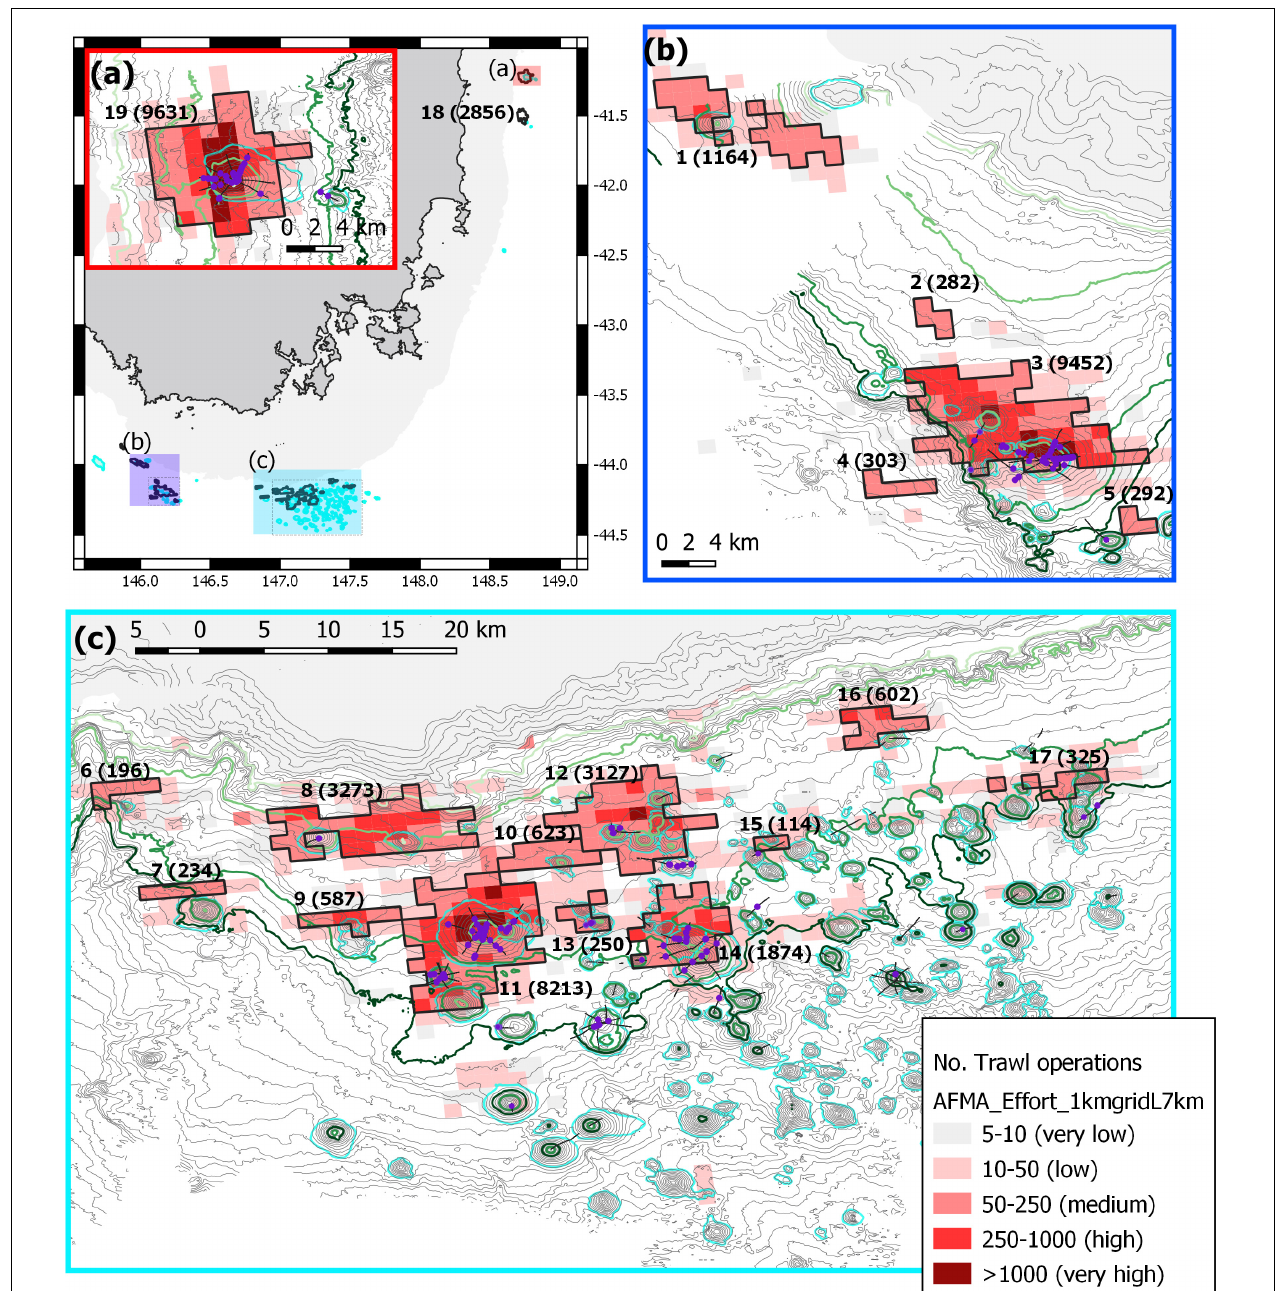
FIGURE 5 | Map of region showing the number of trawl operations and categories of effort. Trawl data mapped into 1 km cells with concentrations of effort shown as bounded “trawl blocks” (total number of operations tallied in parentheses): 1 – Sharks Tooth; 2 – no ID; 3 – Main Matt – including NW Matt; 4 – no ID; 5 – Z99; 6 – Noddys Knob; 7 –Growler; 8 – Andys – Mackas; 9 – Lorna – Belinda; 10 – Z61; 11 – Pedra; 12 – Corvina Group; 13 – Conger; 14 – Sisters Seamount; 15– Brians; 16 – Patience; 17 – Atoll Group; 18 – St Patricks Head; 19 – St Helens. Video transects are shown as black lines and observations of lost gear, gear marks and trawl scars (purple circles) are highlighted. Contours are 50 m intervals with 650, 950, 1,350, and 1,500 m highlighted as light to dark green; the seamounts are outlined (cyan). (a) Overview map showing the 500 m depth mask and the relative locations of the three maps, the inset of (a) effort map of the seamounts off St Helens; (b) eastern deep edge of the Tasman Fracture AMP; (c) western edge of the Huon AMP.